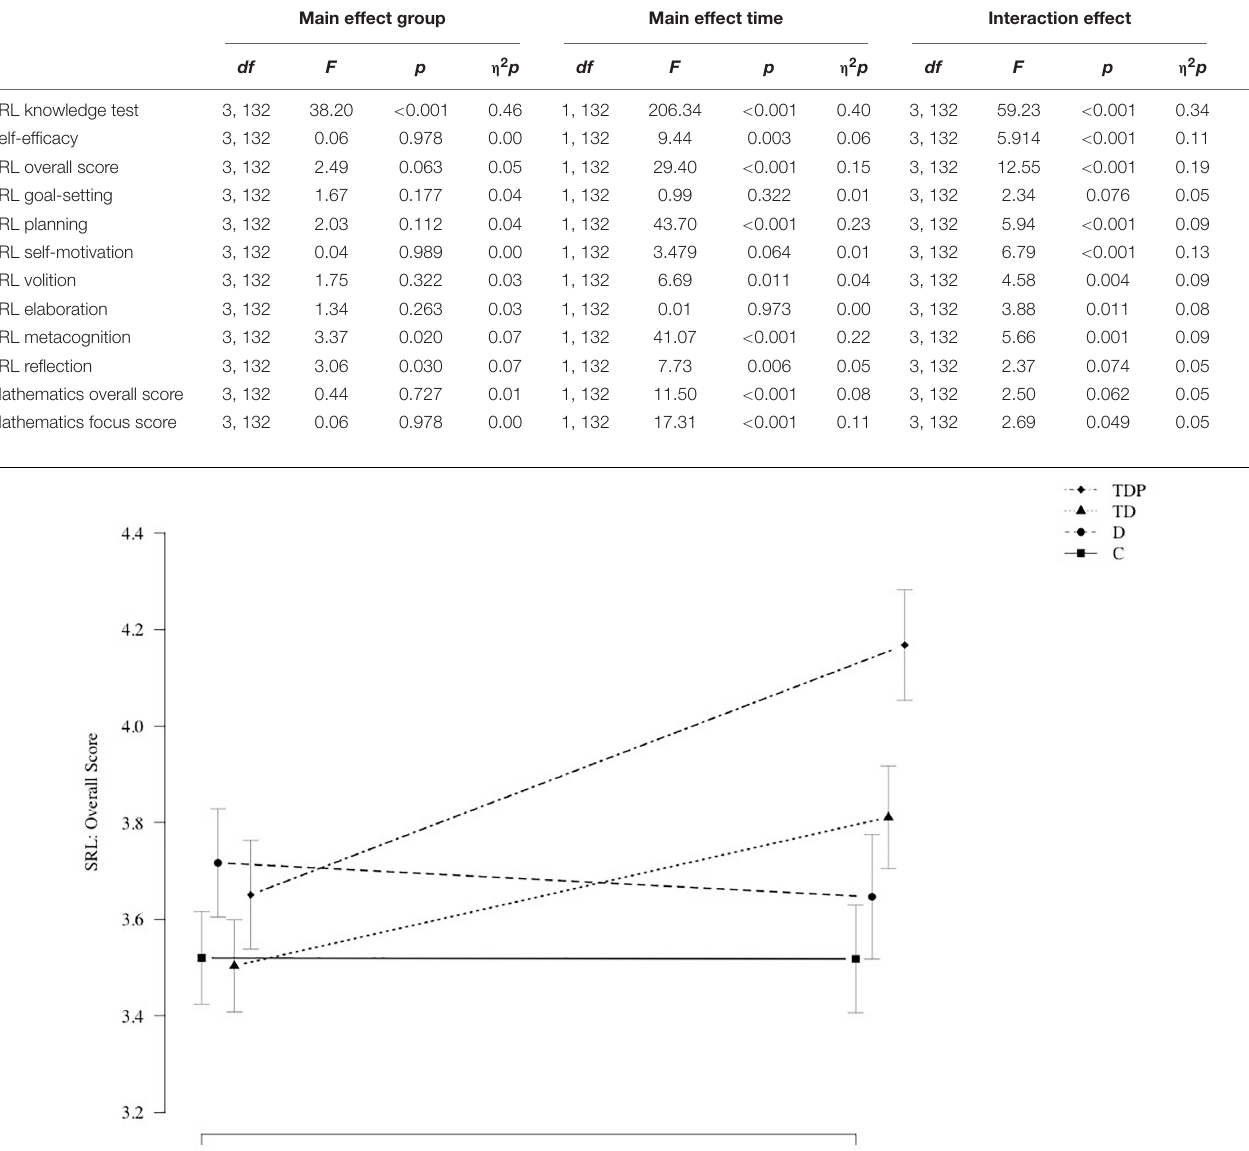
TABLE 2 | Univariate repeated-measures ANOVAs for self-regulated learning (SRL) knowledge, self-efficacy, overall SRL score, SRL subscales, mathematics overall score, and mathematics focus score on pre- and post-tests.